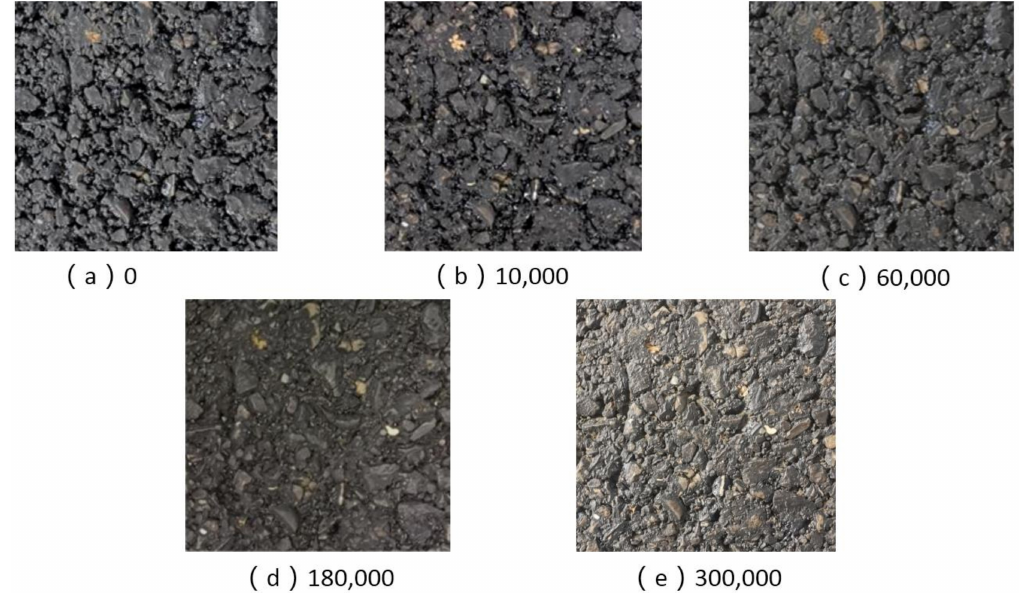
Figure 11. Fixed area of the RS-97 after di ff erent load